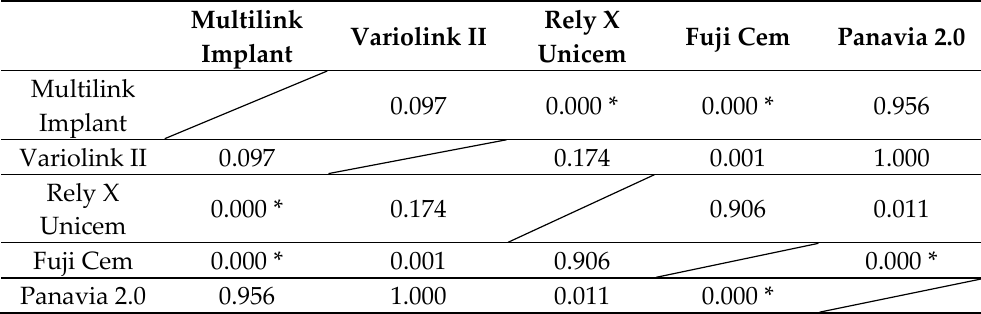
Table A5. Comparison of the different adhesives during the pull-off test: Vita Suprinity.